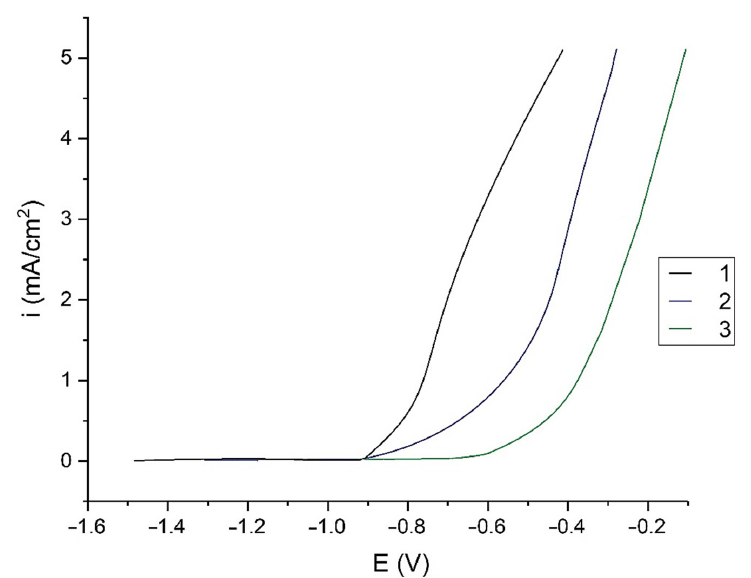
Figure 5. Anode polarization curves with formed organosilane films on the surface of aluminium and clean metal in a solution of 0.4 M H 3 BO 3 + 0.1 M Na 2 B 4 O 7 + 0.01 M NaCl pH 6.7: (1) clean Al; (2) Al + VS; (3) Al + DAS.